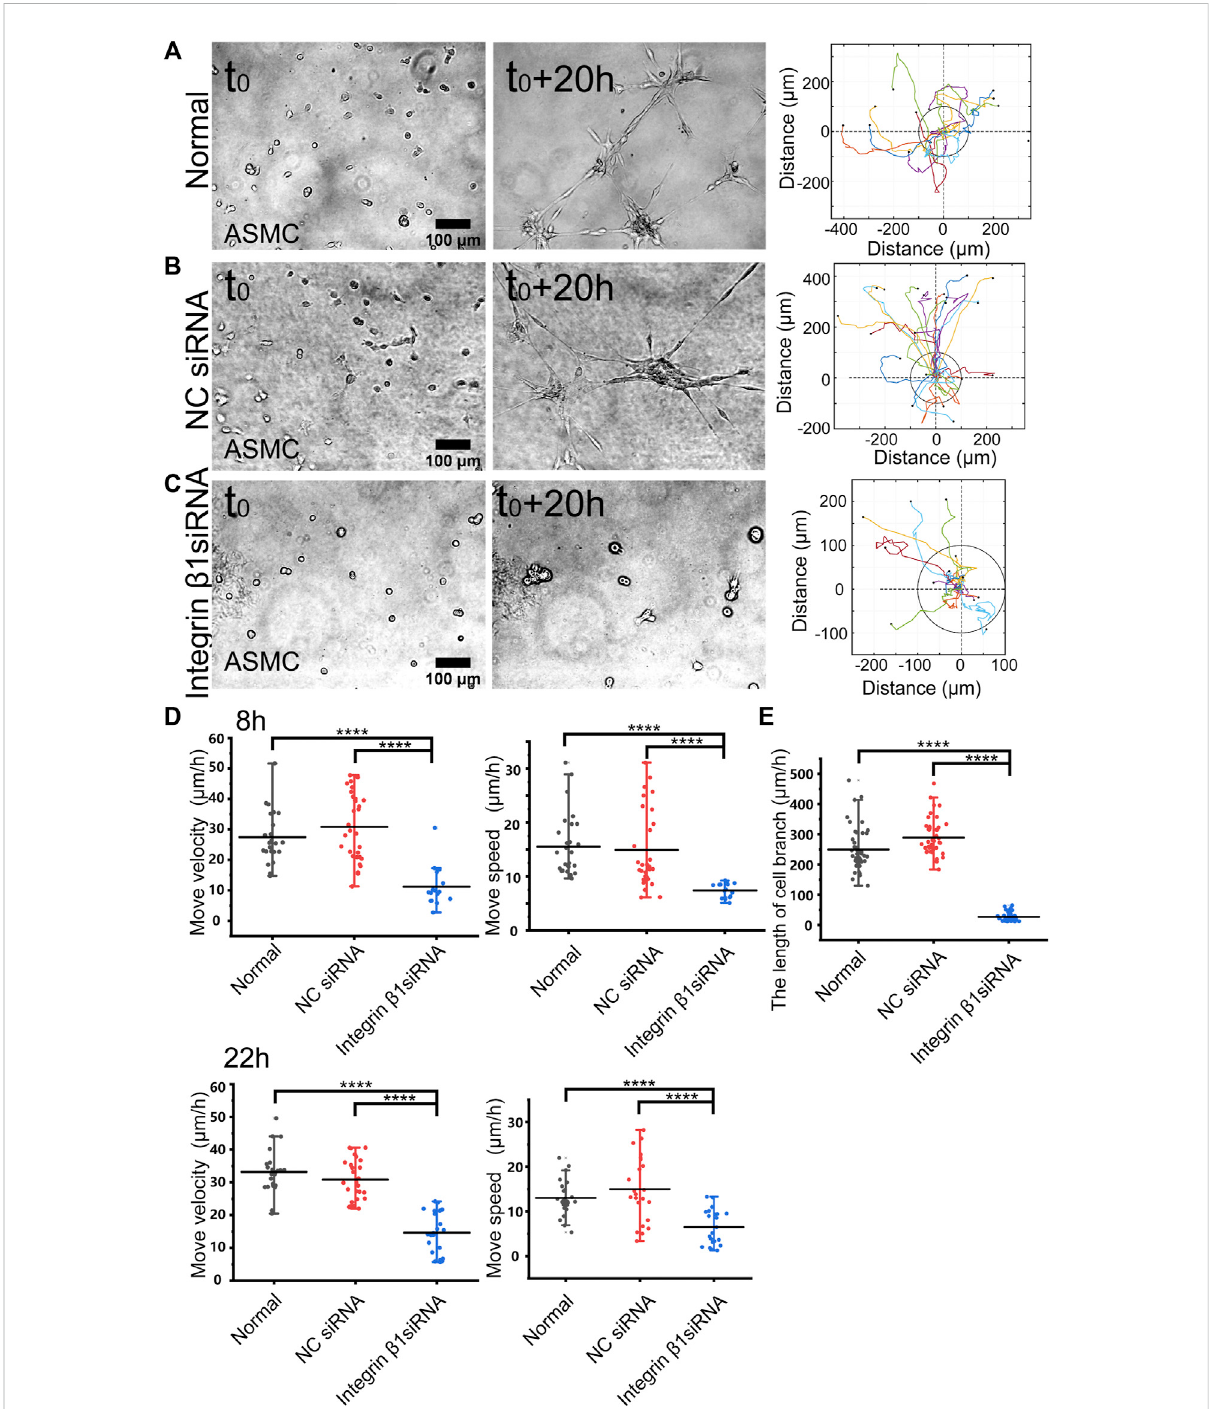
FIGURE 3 Roleofintegrin β 1incelldirectionalmigration. ASMcells weretransfectedwith control orITGB1 siRNA,and after72 h,thecellswereseededon the hydrogel for time-lapse imaging. (A – C) Cell branching assembly and trajectory analysis in ASM cells under normal condition (A) , or transfected withcontrolsiRNA (B) orITGB1siRNA (C) . (D,E) Statisticalquanti fi cationsofcellmovevelocityandspeedin8 h(toppanel, n =23,34,16,respectively) and 22 h (bottom panel, n = ~23, ~20, 22, respectively) (D) , and assembled branching lengths ( n = 44, 44, 48, respectively) (E) under the indicated